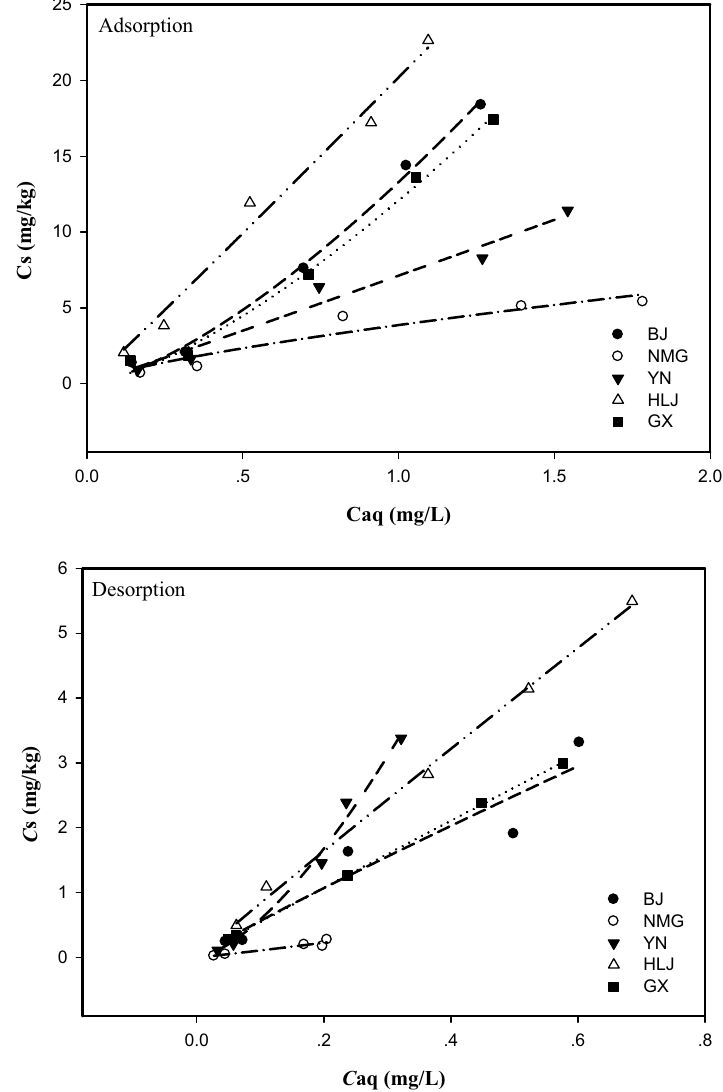
Figure 2. Adsorption–desorption isotherms derived from Freundlich equations for QUN in